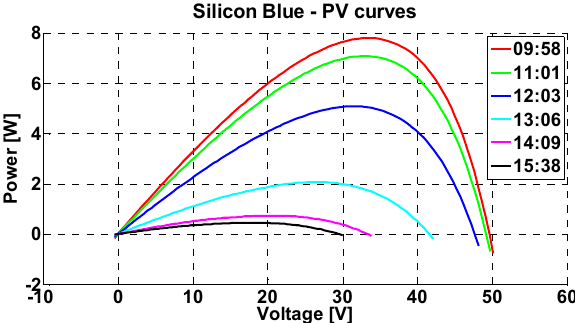
Photonics 2019 , 6 , x FOR PEER REVIEW Figure 17. Blue silicon cell power-voltage curves for different irradiance values.